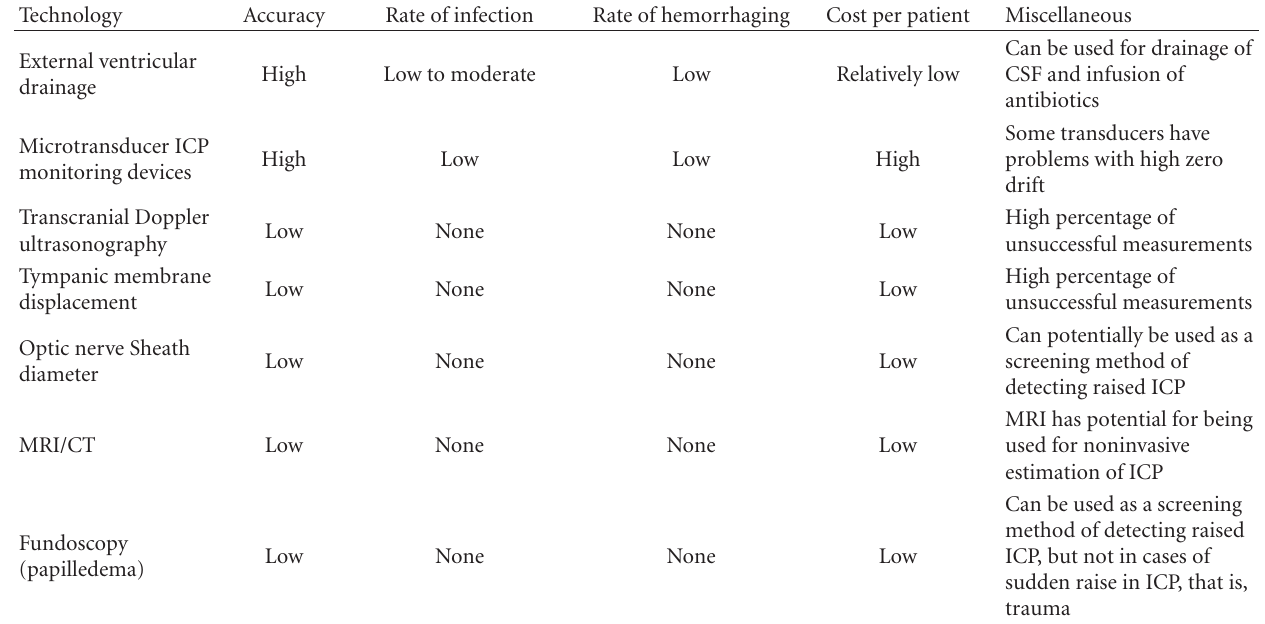
Table 3: The di ff erent technologies